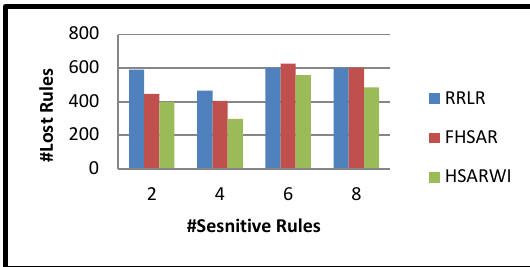
Figure 7. Execution time in chess with MST = 0.95 and MCT = 0.98.